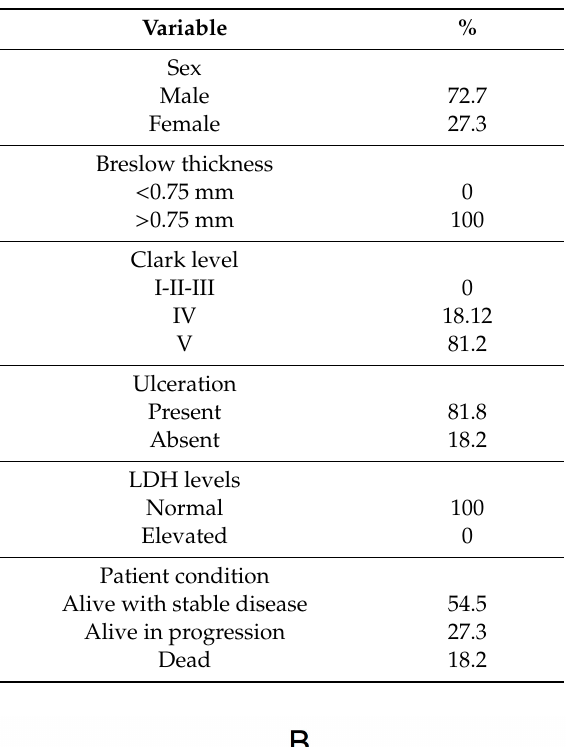
Table 1. Characteristics of the study population.